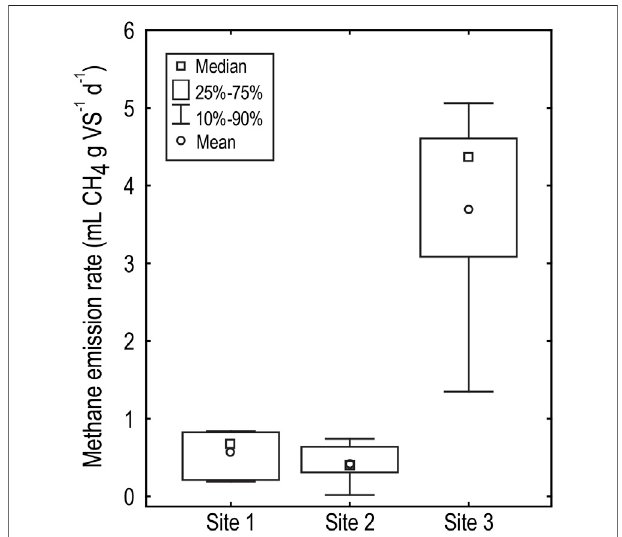
FIGURE 3 | Biological methane potential (mL g VS -1 d -1 , mL of methane produced per gram of volatile solids added to the incubation per day, where volatile solids represents the degradable organic material and is measured by combustion at 550 ° C) of sediments from three sampling sites in Little Nerang Dam when incubated with nutrient media. Site locations are shown in Figure 1D